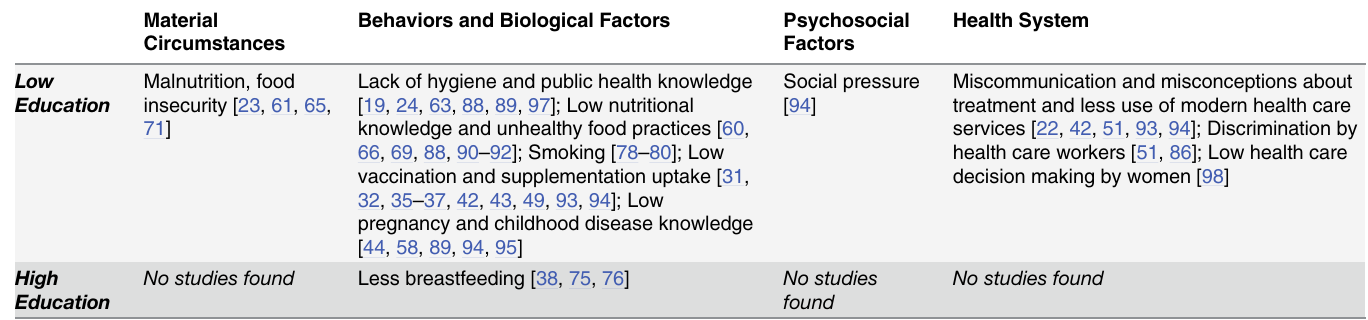
Table 3. Education and Child Health in